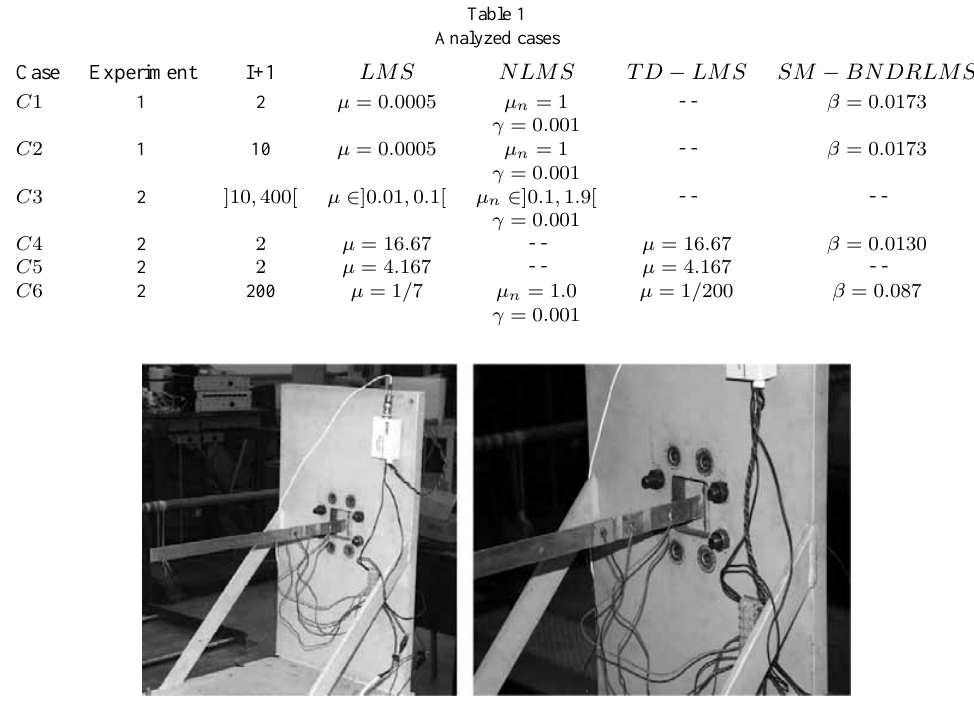
Fig. 2. Experimental setup: general view (left) and zoom on the sensing-actuating system (right).